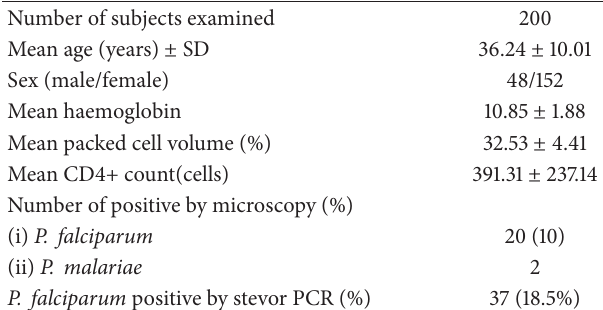
Table1:EnrollmentdataoftheHIVpatientsattendingIHVNClinic recruited into the